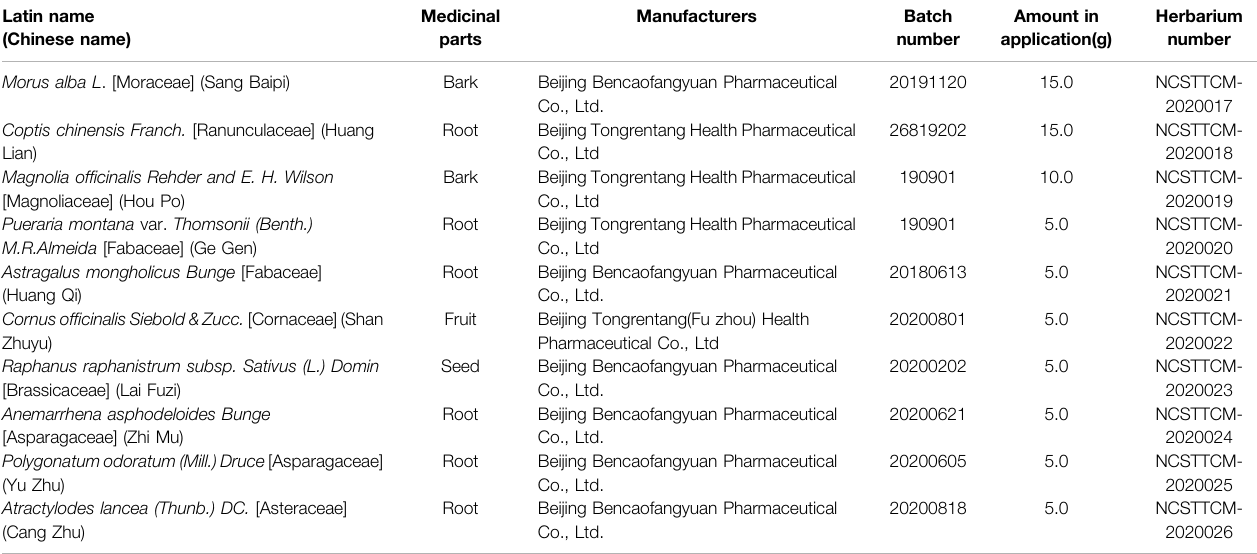
TABLE 1 | Details of SHTXF (one